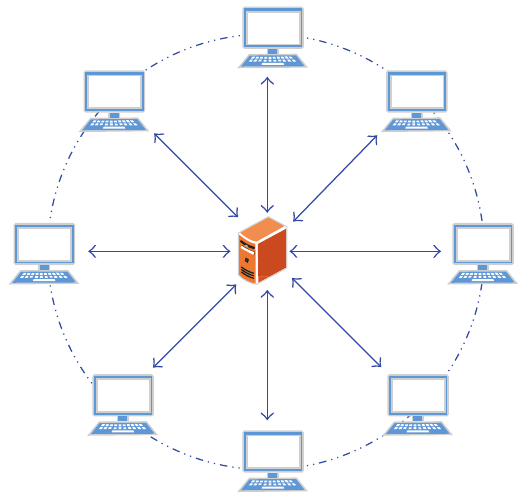
Figure 2: The communication structure for centralized control. various fields, and the discussions of synchronization prob- lems for complex networks have been extensively launched. However, in practice, the state variables of some network nodes are not observable or measured. Therefore, it is necessary to investigate the possibility of pinning a coupled network by adding controllers to those nodes, which can be measured or